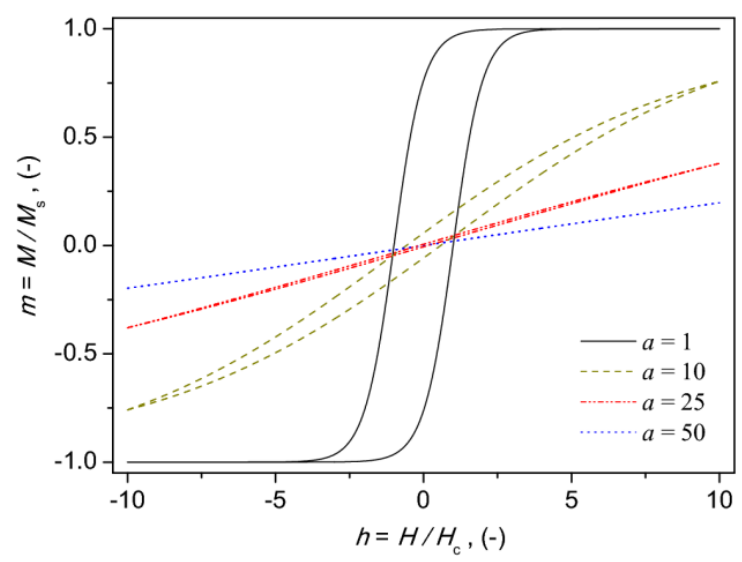
Figure 10. The effect of variation of a value on the shape of hysteresis loops simulated with the T( x ) model.